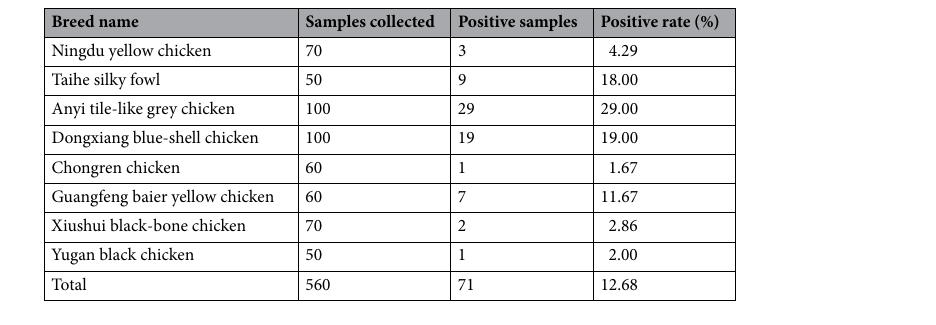
Table 1. ALV-Positive rate in the farms investigated in this